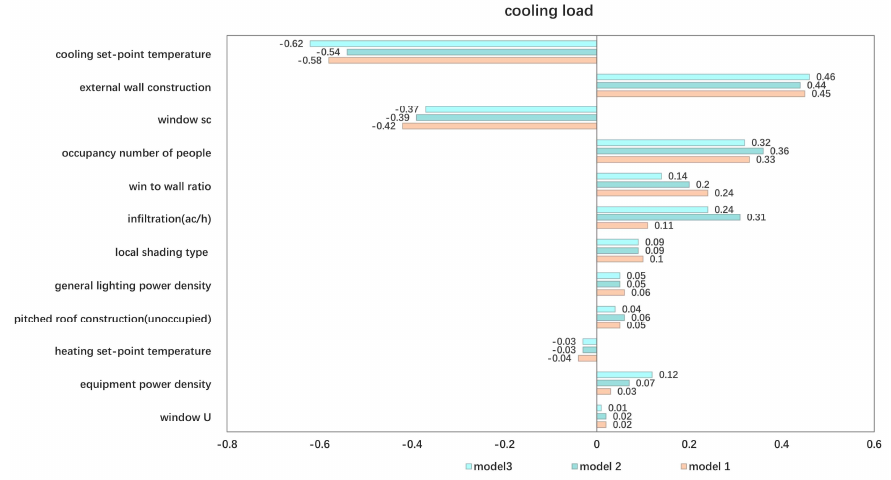
Figure 14. SRC for each parameter for the cooling load.